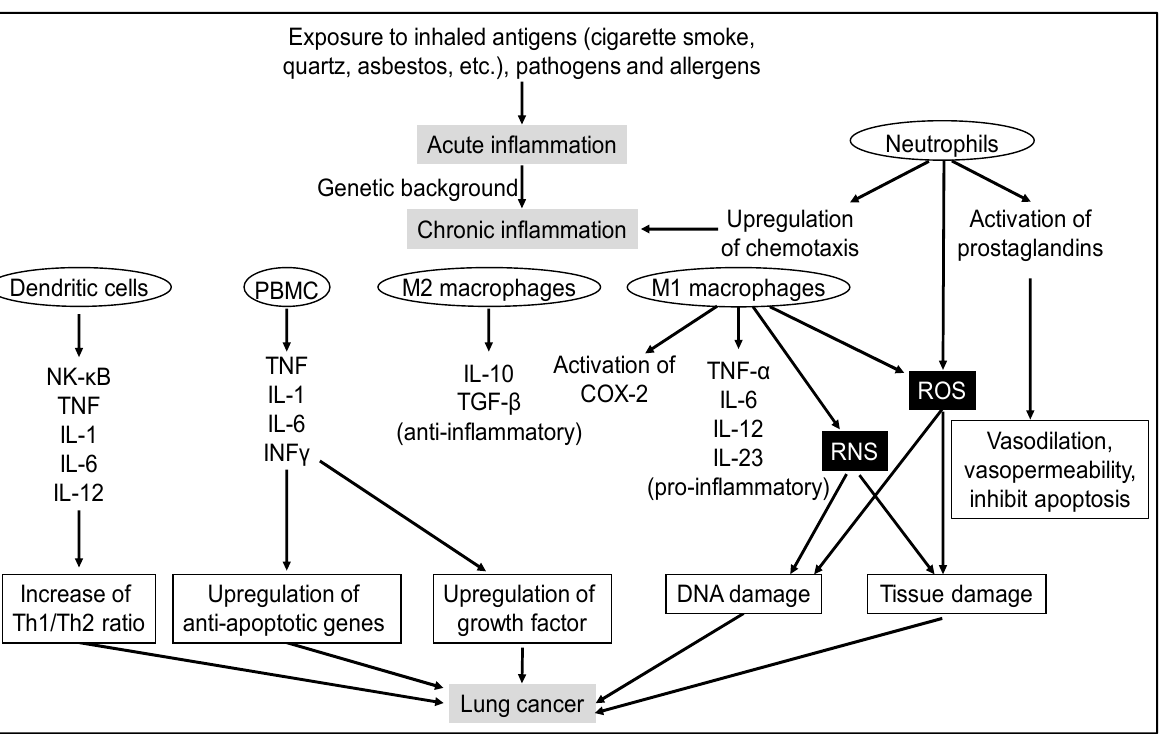
Figure 2. Signaling pathways of inflammatory-mediated lung carcinogenesis.